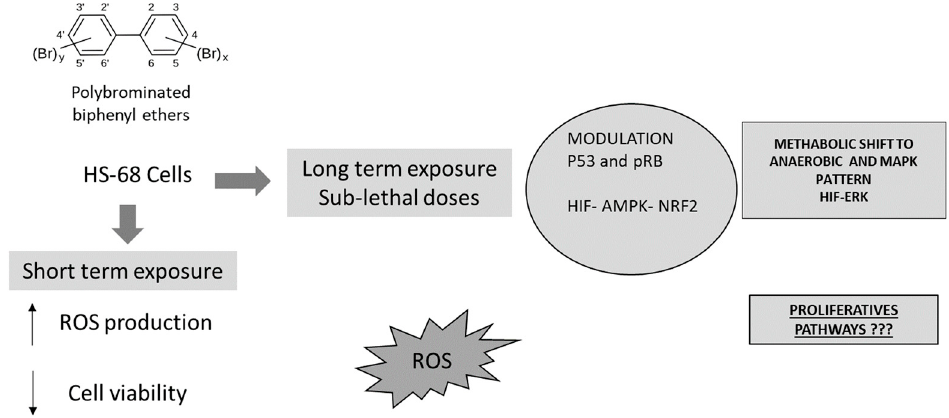
Figure 6. Proposed pathway explaining some biochemical effects, induced in vitro by PBDEs, on cell cycle, antioxidant status, metabolism and proliferation.